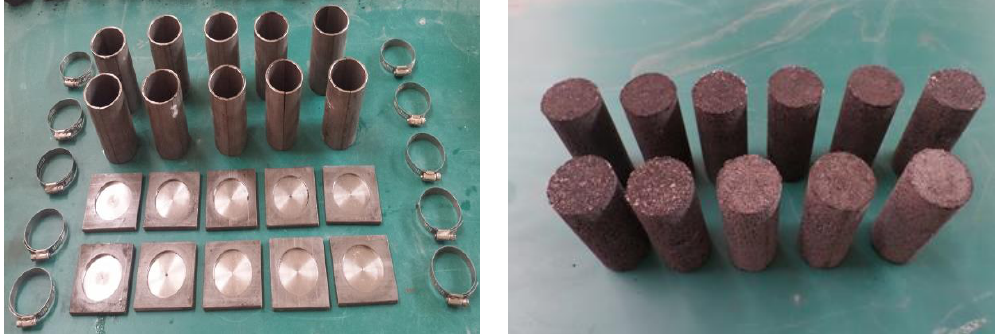
Figure 1. Test piece making mold and some test pieces.